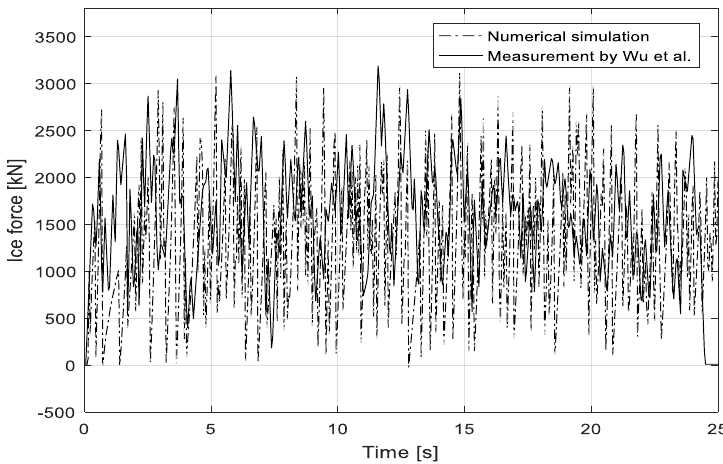
Figure 17. Time history of ice force from the measurement and simulation for test 306.